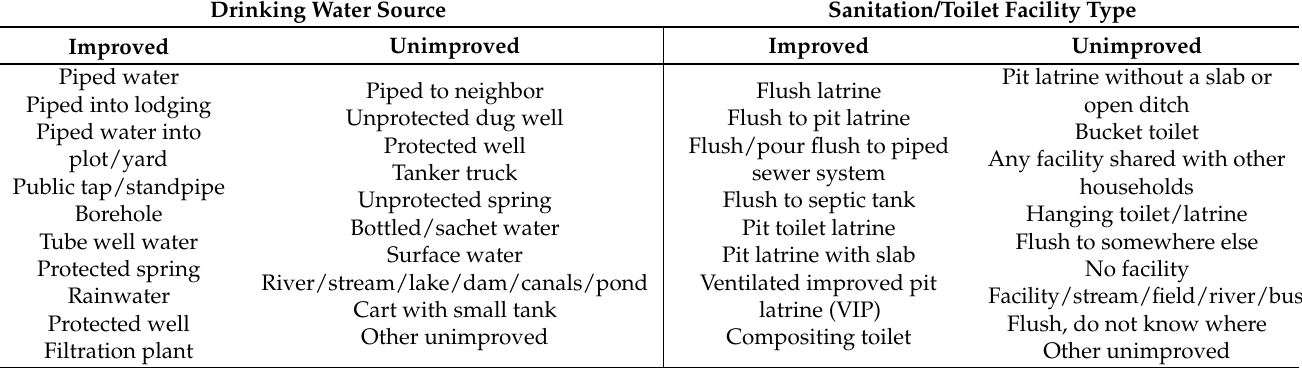
Table 1. Description of water and sanitation